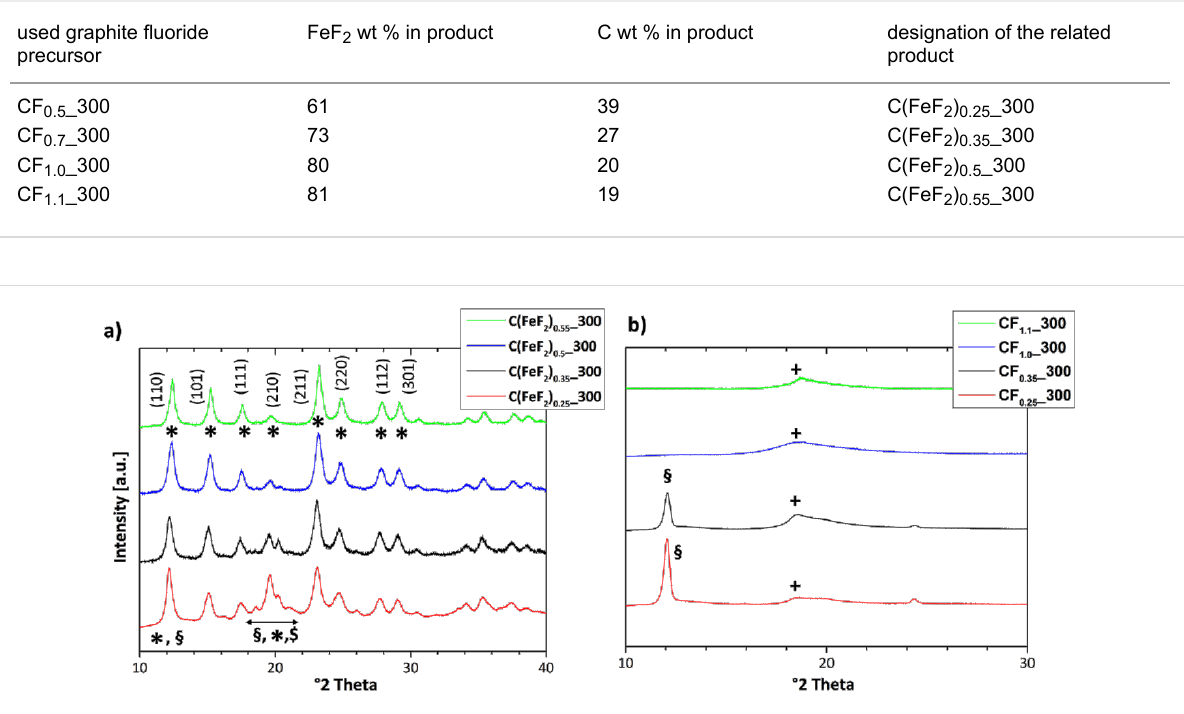
Figure 2: XRD pattern (Mo K α ) of: a) Nanocomposites with different C/F ratio, b) CF x precursors. *:FeF 2 ; §:C (graphite); +: CF x ; $:iron